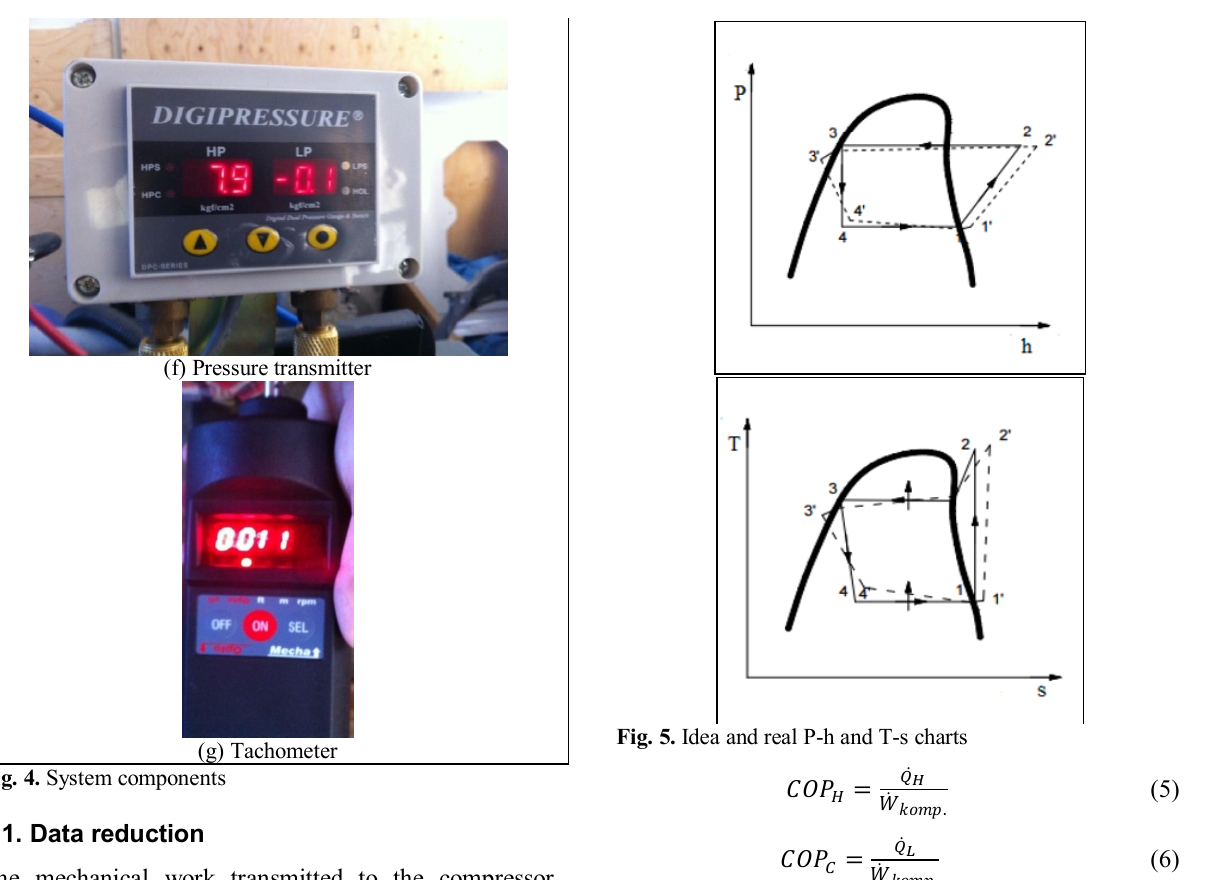
Fig. 4. System components